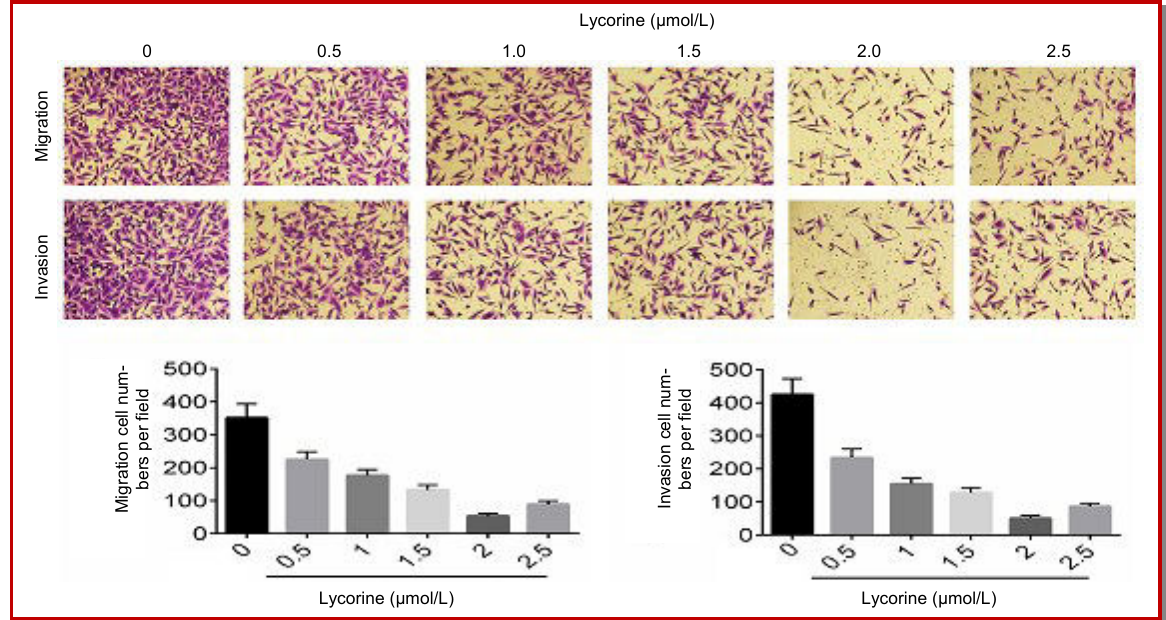
Figure 2: Lycorine suppresses migration and invasion of MDA-MB-231 breast cancer cells in a dose-dependent